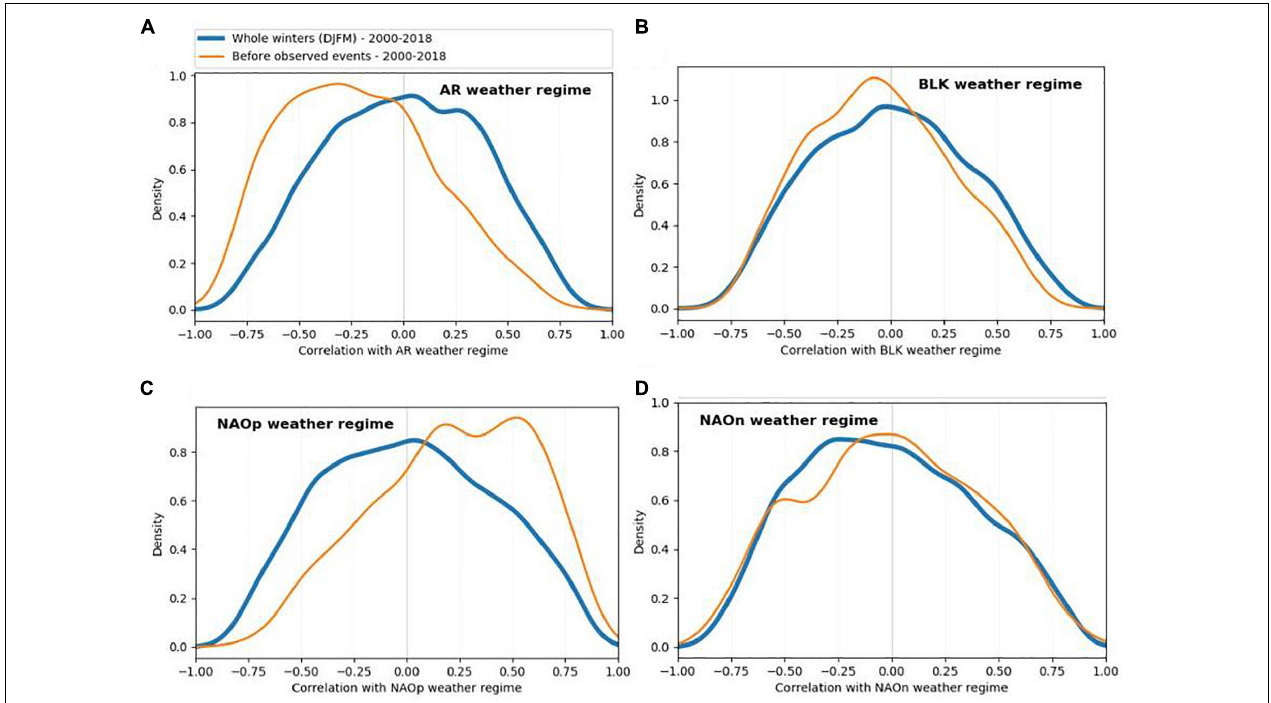
FIGURE 6 | Kernel density based on the correlation values calculated between the atmospheric sea level pressure and (A) the Atlantic Ridge (AR), (B) the Scandinavian Blocking regime (BLK), (C) the positive (NAOp) and (D) negative (NAOn) phases of the NAO for the winter months of the period 2000–2018. Kernel density curves were calculated by considering either all winter months from 2000 to 2018 (blue curve) or only the 14-day periods before extreme low salinity events using in situ observations (orange curve).